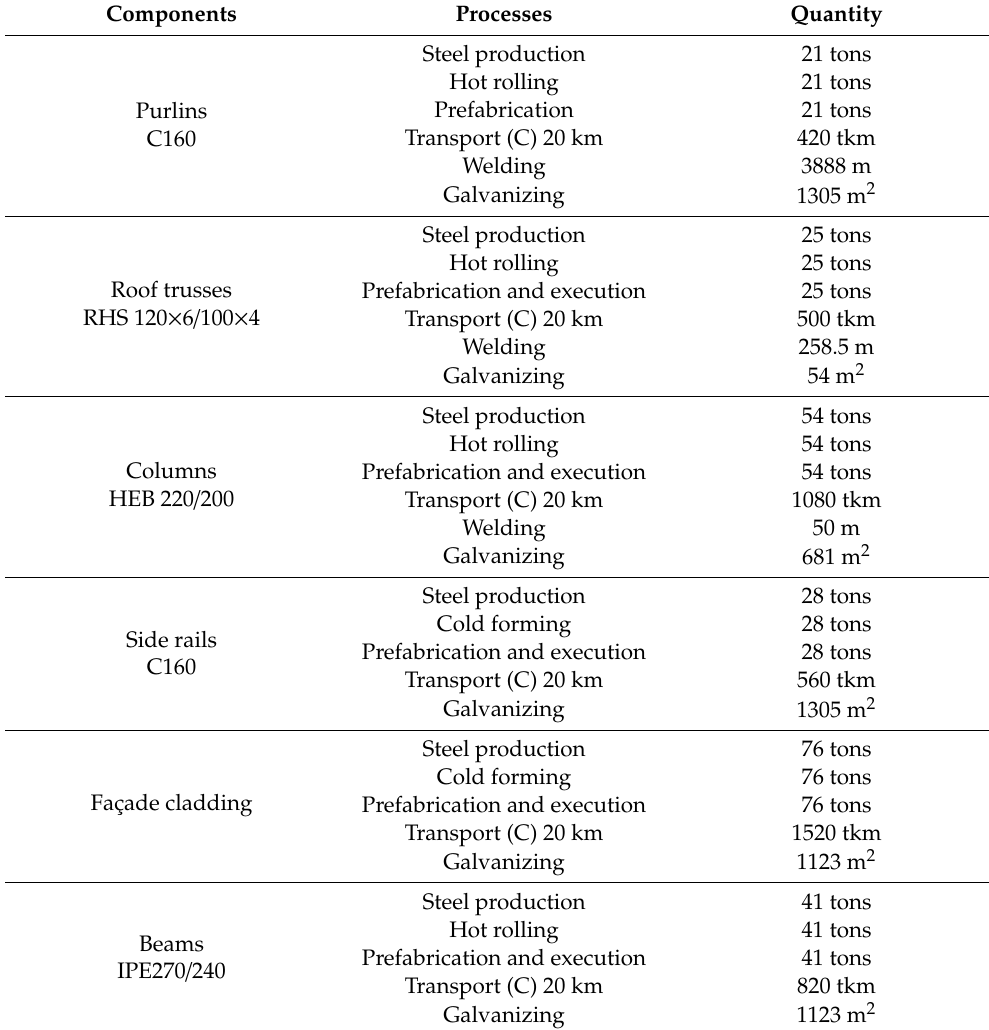
Table 2. Inventory analysis of steel frames o ffi ce building.